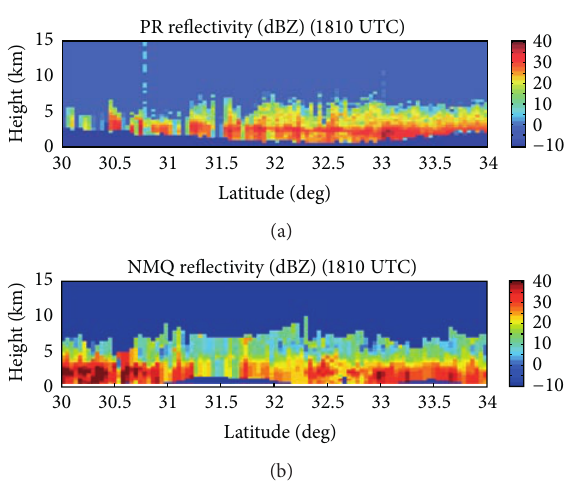
Vertical profile reflectivity (VPR) Plot for radar: KCLX